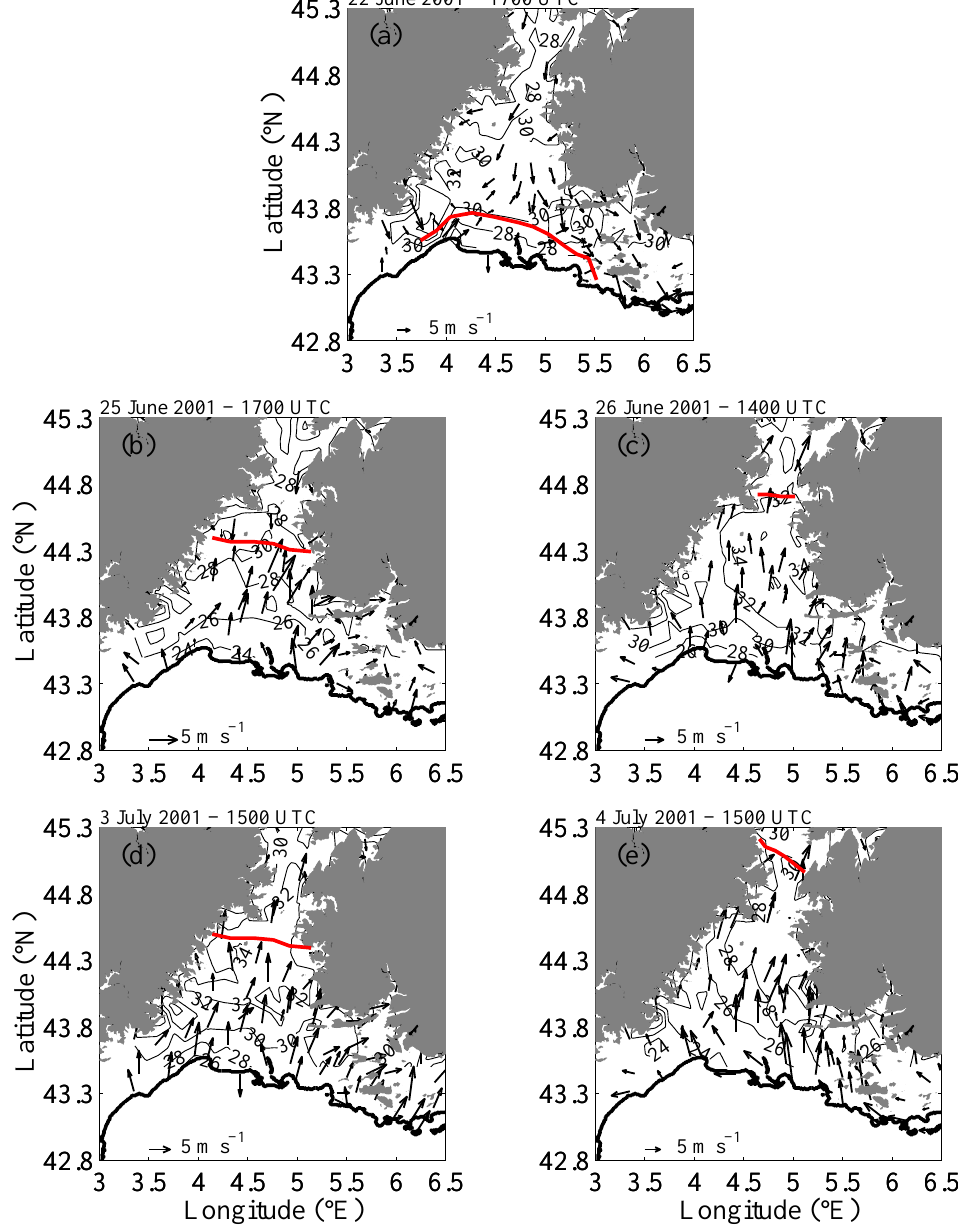
Fig. 3. 10-m wind and 2-m temperature fields from the operational meteorological stations on 22 June at 17:00 UTC (a) , 25 June at 17:00 UTC (b) , 26 June at 1400 UTC (c) , 3 July at 15:00 UTC and 4 July at 15:00 UTC, corresponding approximately to the Falcon flight hours. Arrows indicate the wind speed (see scale) and direction. The isotherms are solid lines with an increment step of 2 ◦ C. The thick red and black lines indicate the location of the sea breeze front and the coastline, respectively. The topography is shaded in grey when higher than 500 m above sea level. 28